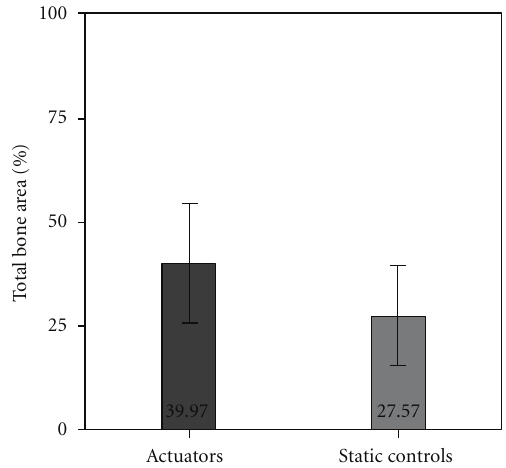
Figure 4: Total bone area measured around actuators and static controls, expressed in percentage. Bars represent means and error bars standard